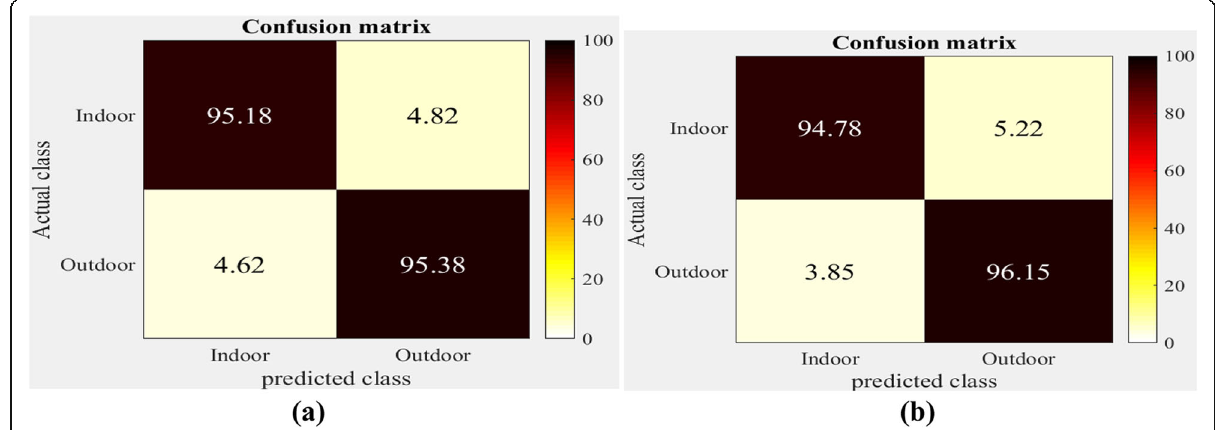
Fig. 7 Confusion matrices obtained for spatial color gist wavelet descriptors on Indian institute of technology madras-scene classification image database two dataset. a Linear kernel; b Radial basis function kernel